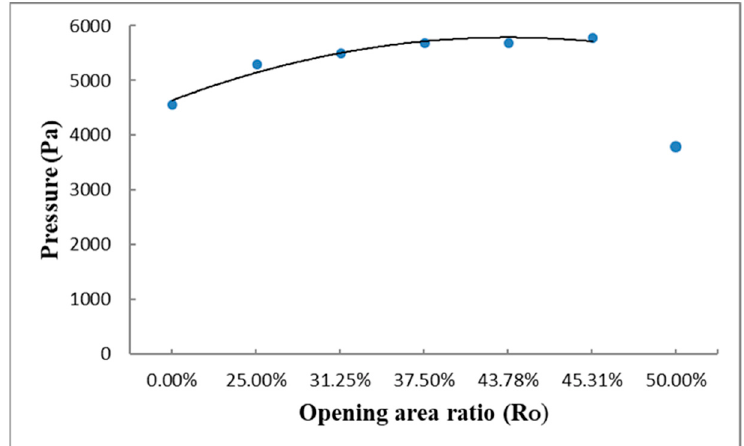
Figure 15. Air-pressure corresponding to opening ratio of OWC gate.